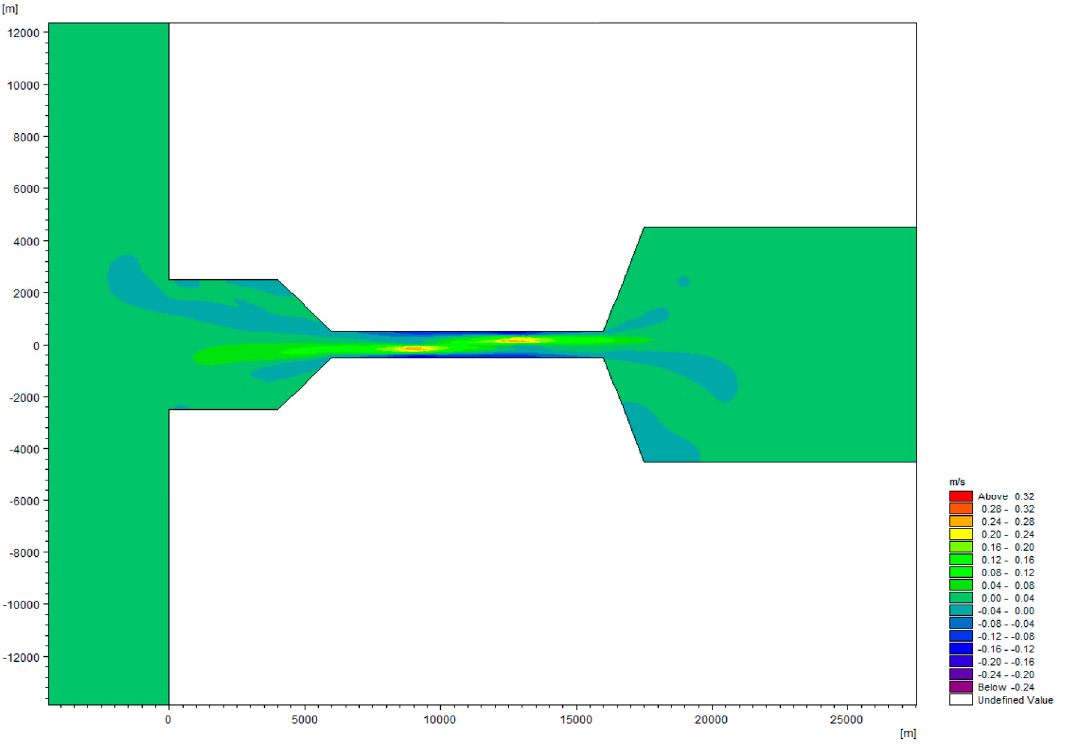
Figure 5. Differences in current speed between scenarios with and without turbines, i.e., difference between the scenario without TED and scenario with TED in m/s. The values are averaged across one tidal cycle (i.e., 12.4 h). Outside the displayed area changes in current speed were less than 0.004 m/s.